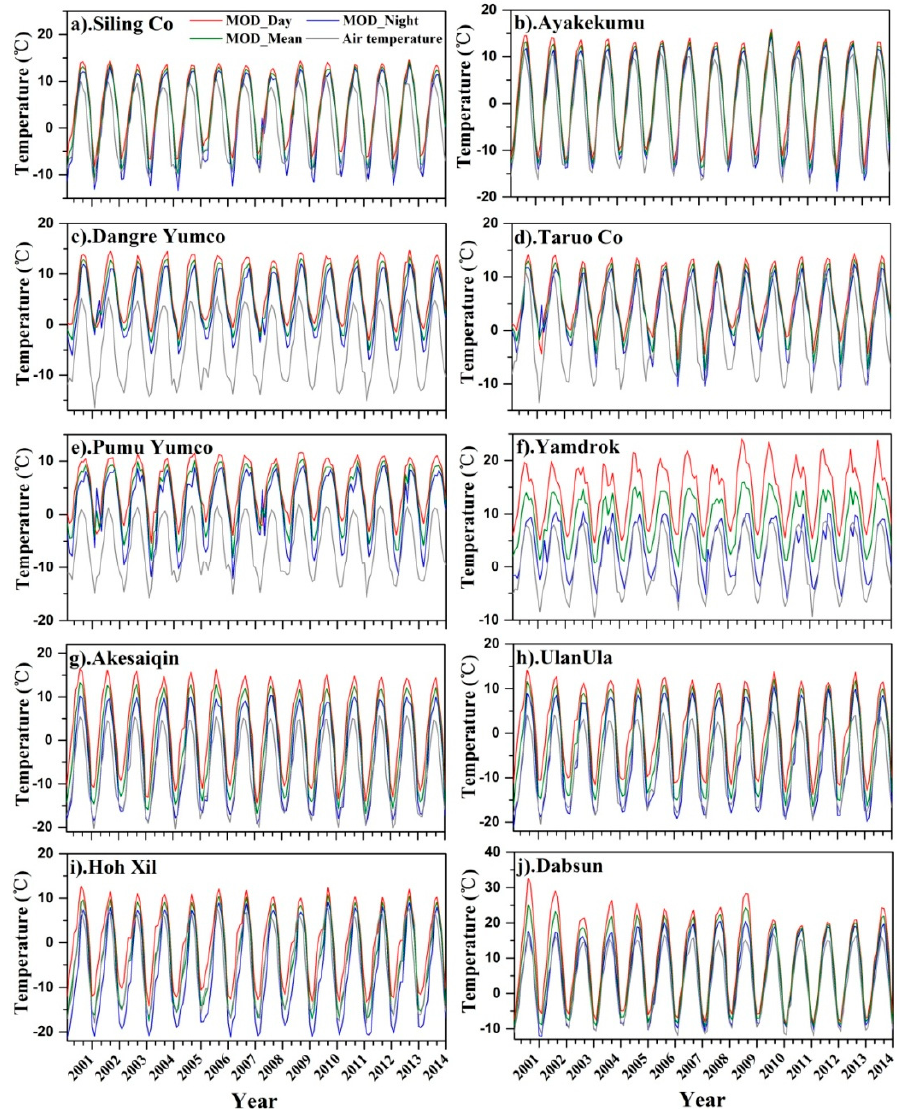
Figure 11. The variations of monthly air temperature over lakes and averaged monthly lake surface temperature derived from MODIS images during 2000 to 2015: ( a ) Siling Co; ( b ) Aykekumu; ( c ) DangreYumco; ( d ) Taruo Co; ( e ) PumuYumco; ( f ) Yamdrok; ( g ) Akesaiqin; ( h ) UlanUla; ( i ) Hoh Xil; and ( j ) Dabsun.